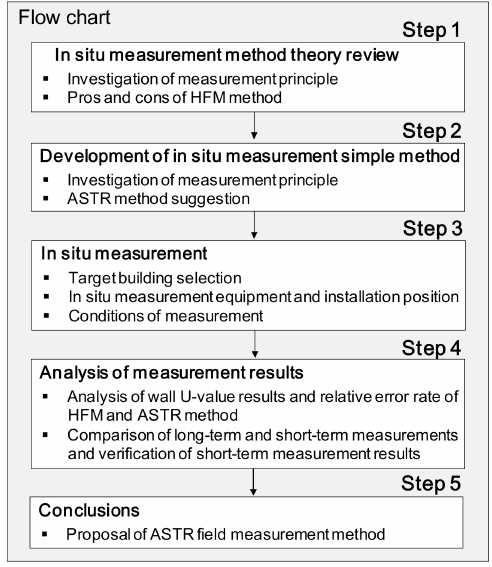
Figure 1. Study process